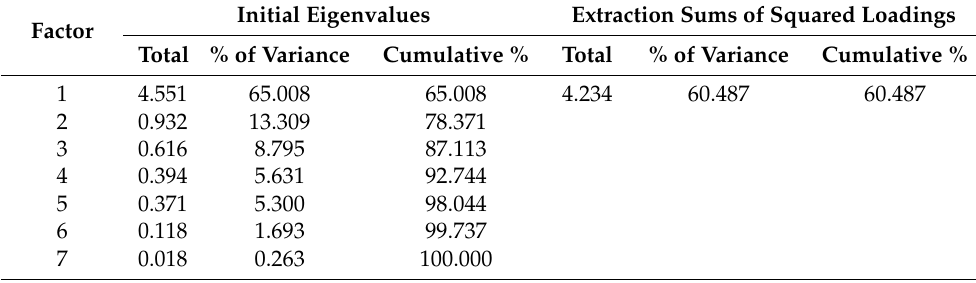
Table 2. Total variance explained.